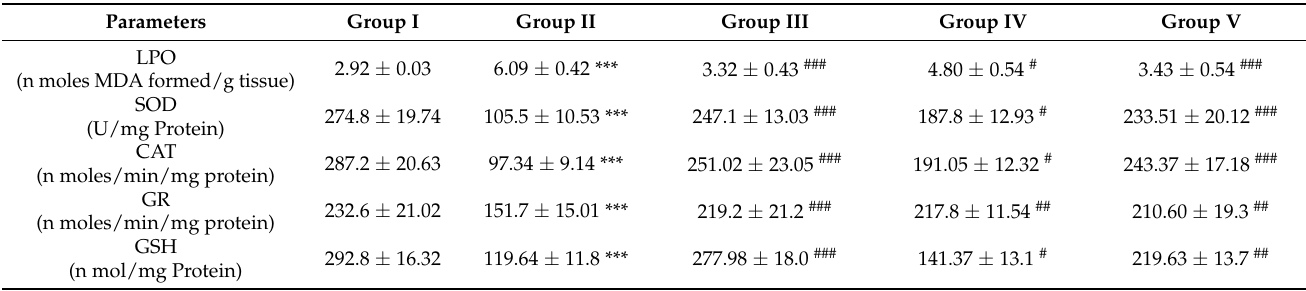
Results are representative of mean ± SE of eight mice per group. Values are significantly different in LiCl and pilocarpine group (*** p < 0.001) as compared to control group. Results that we got are significantly different from LiCl and pilocarpine group as the main comparison is with LiCl and pilocarpine group only ( # p < 0.05, ## p < 0.01 and ### p < 0.001). Group I: Normal saline (10 mL/kg b.w.), Group II: LiCl (3 mEq/kg b.w.) + pilocarpine (30 mg/kg b.w.), Group III: Sodium Valproate (300 mg/kg b.w.) + LiCl (3 mEq/kg b.w.) + pilocarpine (30 mg/kg b.w.), Group IV: zingerone (25 mg/kg b.w.) + LiCl (3 mEq/kg b.w.) + pilocarpine (30 mg/kg b.w.), Group V: zingerone (50 mg/kg b.w.) + LiCl (3 mEq/kg b.w.) + pilocarpine (30 mg/kg